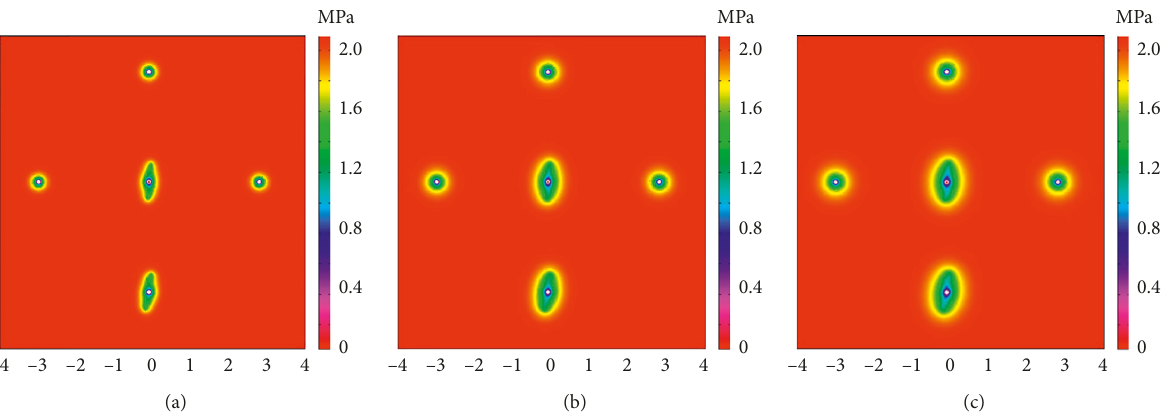
Figure 13: Distribution diagram of gas pressure under varying gas drainage times. (a) Two days. (b) Six days. (c) Ten days.